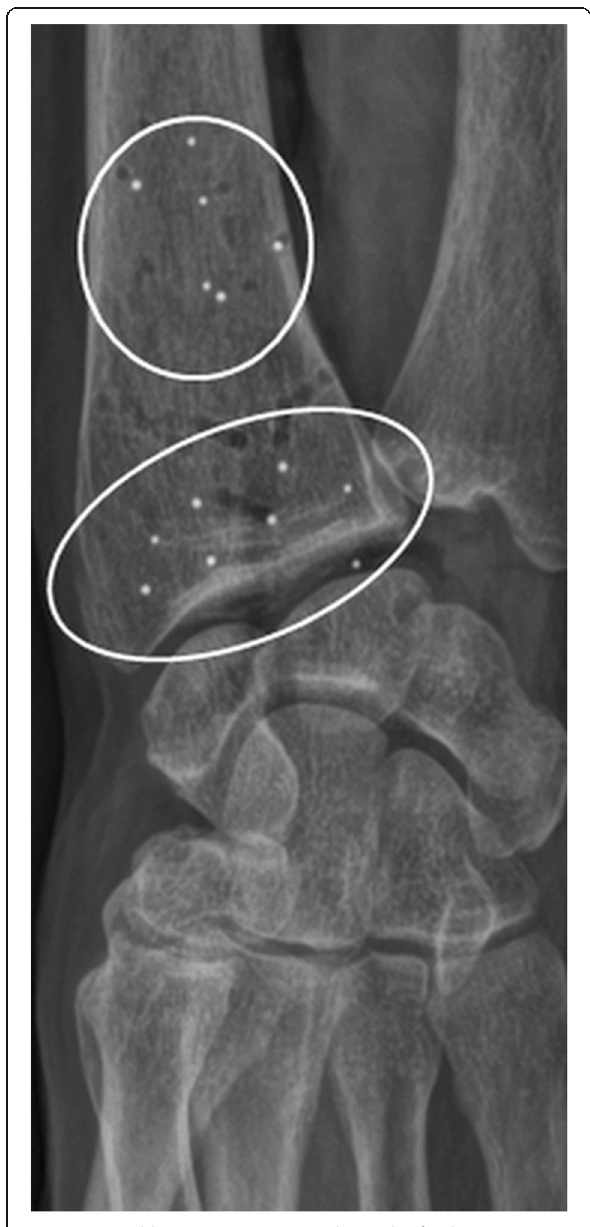
Fig. 1 Cross-table posterior-anterior radiograph of a donor arm. Proximal and distal segments (white circles) with tantalum